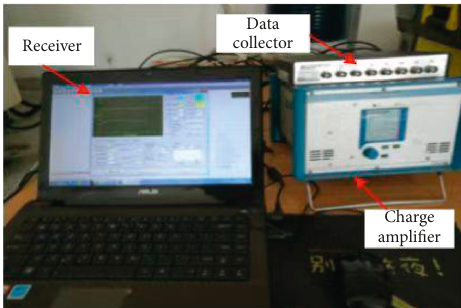
Figure 6: Force measurement system (charge amplifier, data collector, and